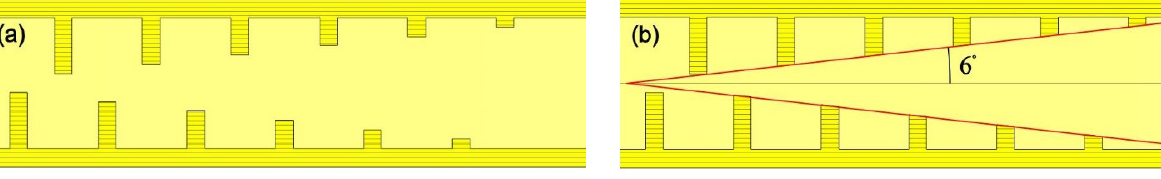
Figure 4. Electromagnetic parameters of the SWS. ( a ) Dispersion diagram (blue lines) and 19.75-kV beam line (red line); ( b ) interaction impedance. On-axis impedance (blue line) and the impedance averaged over the 75 um × 750 um sheet-beam cross-section (red line) are plotted.